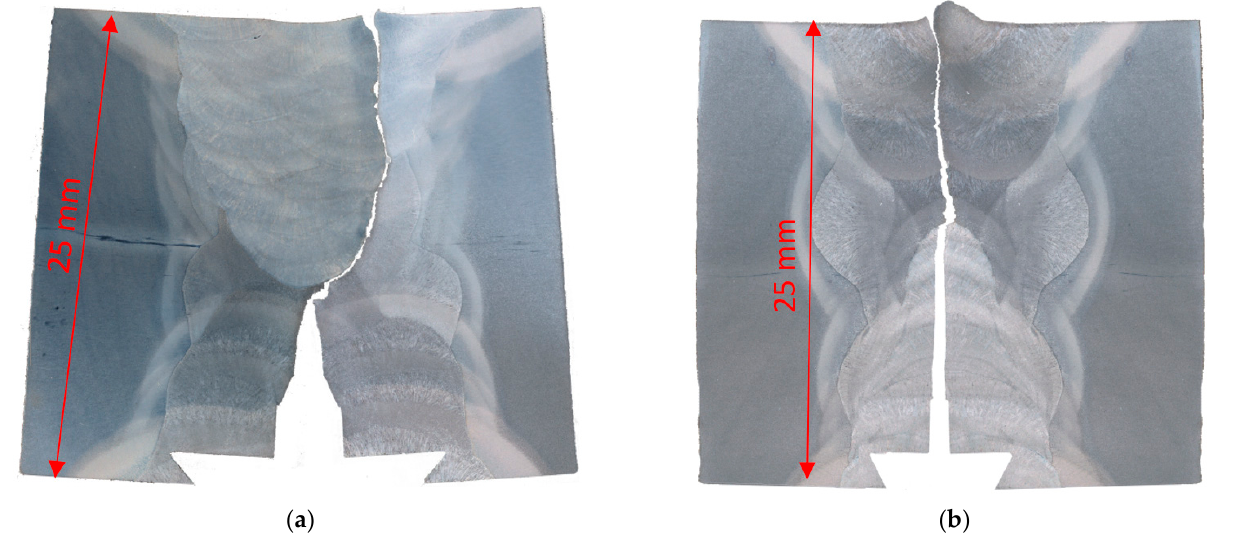
Figure 12. Crack path after fracture toughness testing of both specimens, etched by 4% Nital: ( a ) UM/OM configuration 1 (initial crack in UM); ( b ) OM/UM configuration 2 (initial crack in OM).